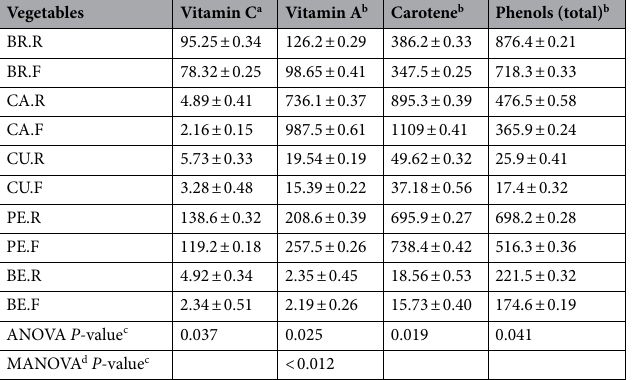
Table 7. Chosen vitamins and phenols in raw and fermented vegetables. The results are the mean ± standard deviation of four repetitions (n = 4) of each vegetable combination. a mg·100 g -1 fresh matter. b µg g -1 fresh matter. c P < 0.05 statistical differences. d Raw/fermented vegetables.